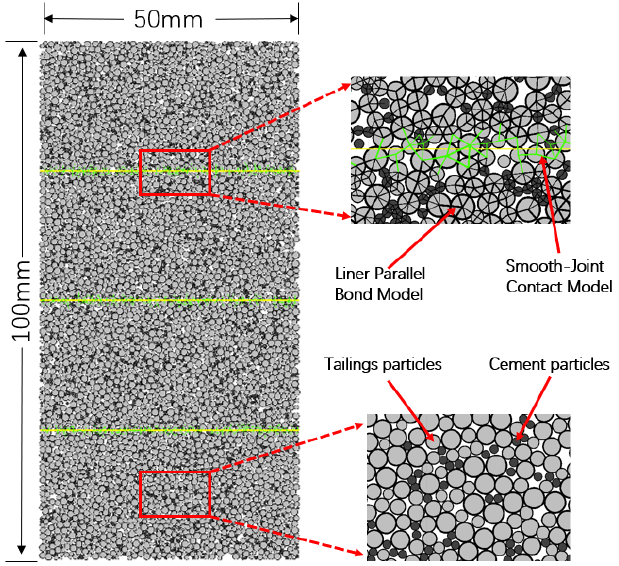
Figure 3. Numerical model of four-layer horizontal filling body. As shown in Figure 3, light color particles represent tailings particles, dark color par- ticles represent cement particles, green lines represent smooth joint contact between par- ticles and black lines represent a parallel bonding model between particles. Without any boundary conditions on both sides of the model, the uniaxial compression test was simu- lated by applying the downward and upward motion rates to the top and bottom walls, and stress–strain, energy and number of cracks during loading were recorded. 3. Results and Discussion 3.1. Analysis of Mechanical Properties of Layered Filling Body 3.1.1. Uniaxial Compressive Strength of Layered Backfill The uniaxial compressive capacity of the filling body is one of the most intuitive standards to test the quality of a filling body. The slurry concentration and filling layer number are essential factors affecting the strength of the filling body. This experiment adopted the LGS5000 press produced by the precise instruments of the Kunshan egret industry. Each group of samples with the average value of the compressive results of the five samples as the test results . If one of the test data of five samples exceeded the average value by 15%, the data would be rejected, and the average value of the remaining data was taken as the test result; the test results are shown in Table 2. Figure 4 is the histogram of compressive strength distribution, from which we can intuitively see the quantitative relationship between the uniaxial compressive strength of the filling body and different filling times or concentrations. The influence degree of slurry concentration and filling times on the uniaxial compressive strength of the filling body was analyzed by two-factor variance, and the results are shown in Tables 3–5. Table 2. Uniaxial compressive strength of layered backfill/(MPa). Slurry Concentration